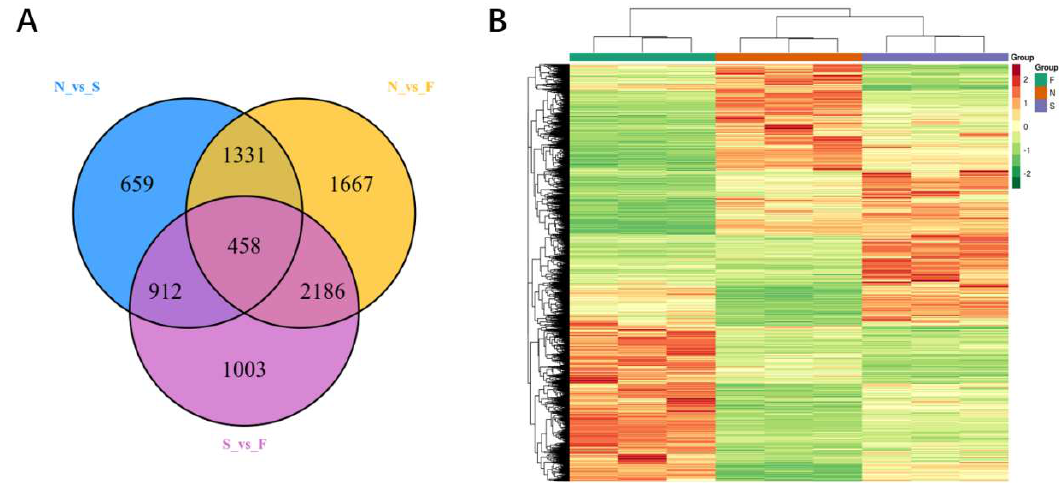
Figure 8. Venn diagram ( A ) and cluster heat map ( B ) of the differentially expressed genes. S (T1) represents long-term severe drought stress imposed at the seedling stage of maize, F (T2) represents long-term severe drought stress imposed at flowering stage of maize, and N (CK) represents control with conventional irrigation.